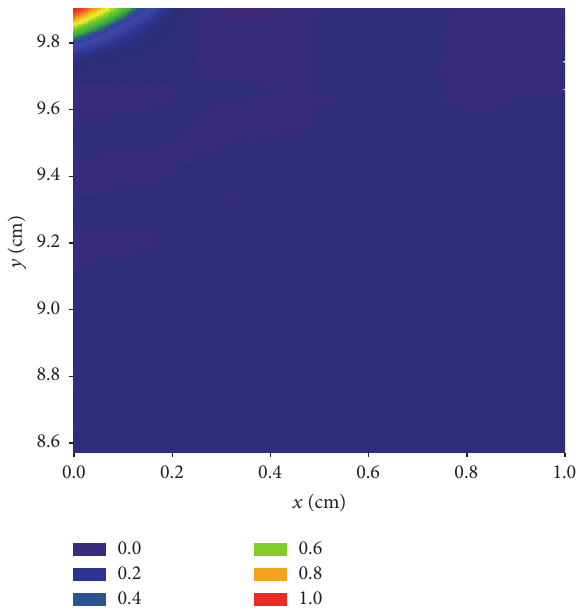
Figure 5: Heat source